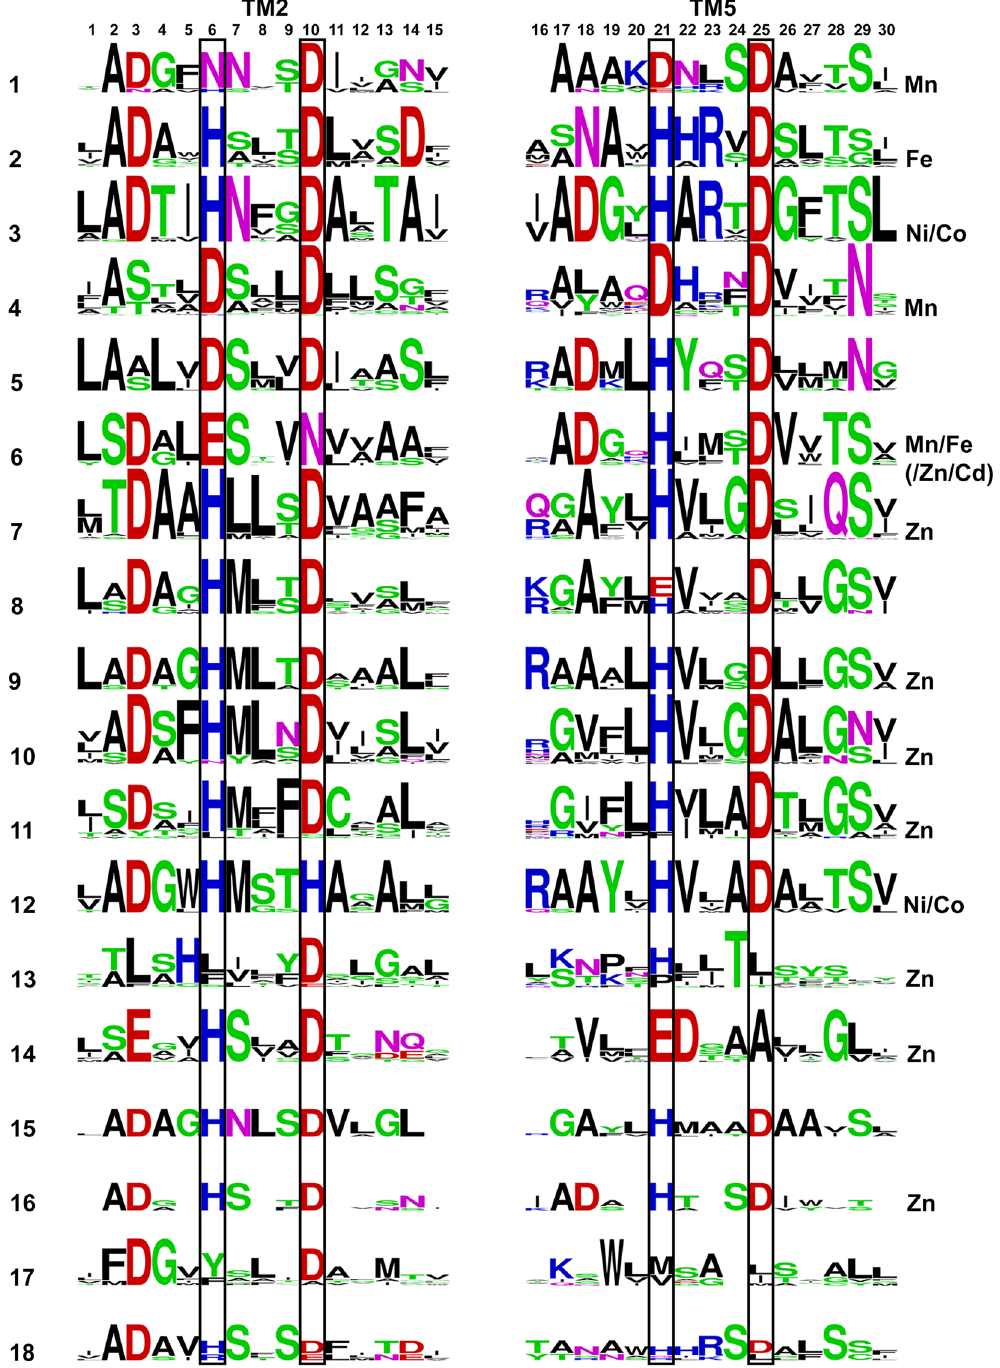
Figure 6. LOGO presentations of all CDF clade A-sites (all at the same scale with a maximal height of 4 bits). Each 15-residue block contains the A-site residues in the TM helix in black boxes plus five residues from the N- and C-terminus. Position 6 overlaps with D45, position 10 with D49, position 21 with H153 and position 25 with D157 in YiiP. Acidic residues (E, D) are presented in red, basic residues (H, K, R) are presented in blue, small/polar (G, C, S, T, Y) are presented in green, amide residues (N, Q) are presented in pink and hydrophobic residues (A, L,V, I, M, P, F, W) are presented in black. Metals shown experimentally to be preferably transported by proteins in a clade are indicated for each clade on the